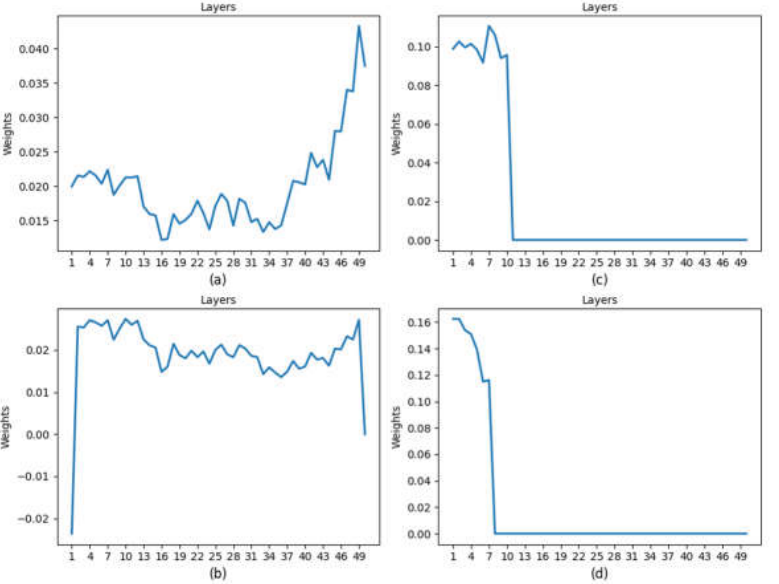
Figure 11. Layers’ relevance weights learned by the proposed class-independent ANNA on CIFAR-10 dataset after training the model using: ( a ) 1 batch; ( b ) 5 batches; ( c ) 6 batches; ( d ) 7 batches.